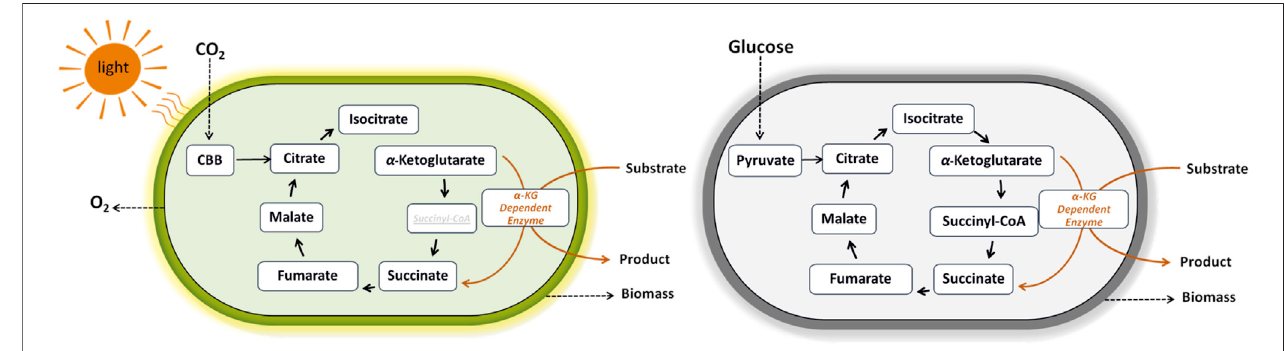
FIGURE 3 | Coupling of α -ketoglutarate dependent oxygenases to phototrophic and heterotrophic metabolism. These enzymes catalyze a remarkable range of reactions, such as hydroxylation, desaturation, and epoxidation. They utilize iron (II) as the metallo-cofactor and α -ketoglutarate as the co-substrate that is oxidatively decarboxylated to succinate and CO 2